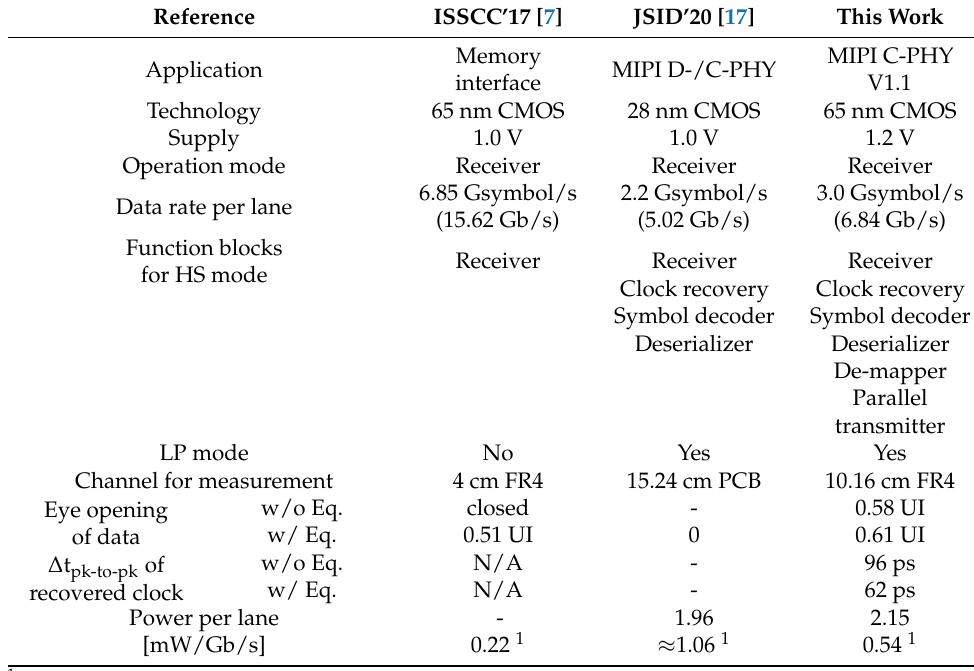
Figure 18. Recovered clock measured according to DEC_CODE[2:0]: ( a ) DEC_CODE[2:0] = 3b’000; ( b ) DEC_CODE[2:0] = 3b’101; ( c ) DEC_CODE[2:0] = 3b’110; ( d ) DEC_CODE[2:0] = 3b’111. Table 1. Performance summary and comparison of proposed MIPI C-PHY